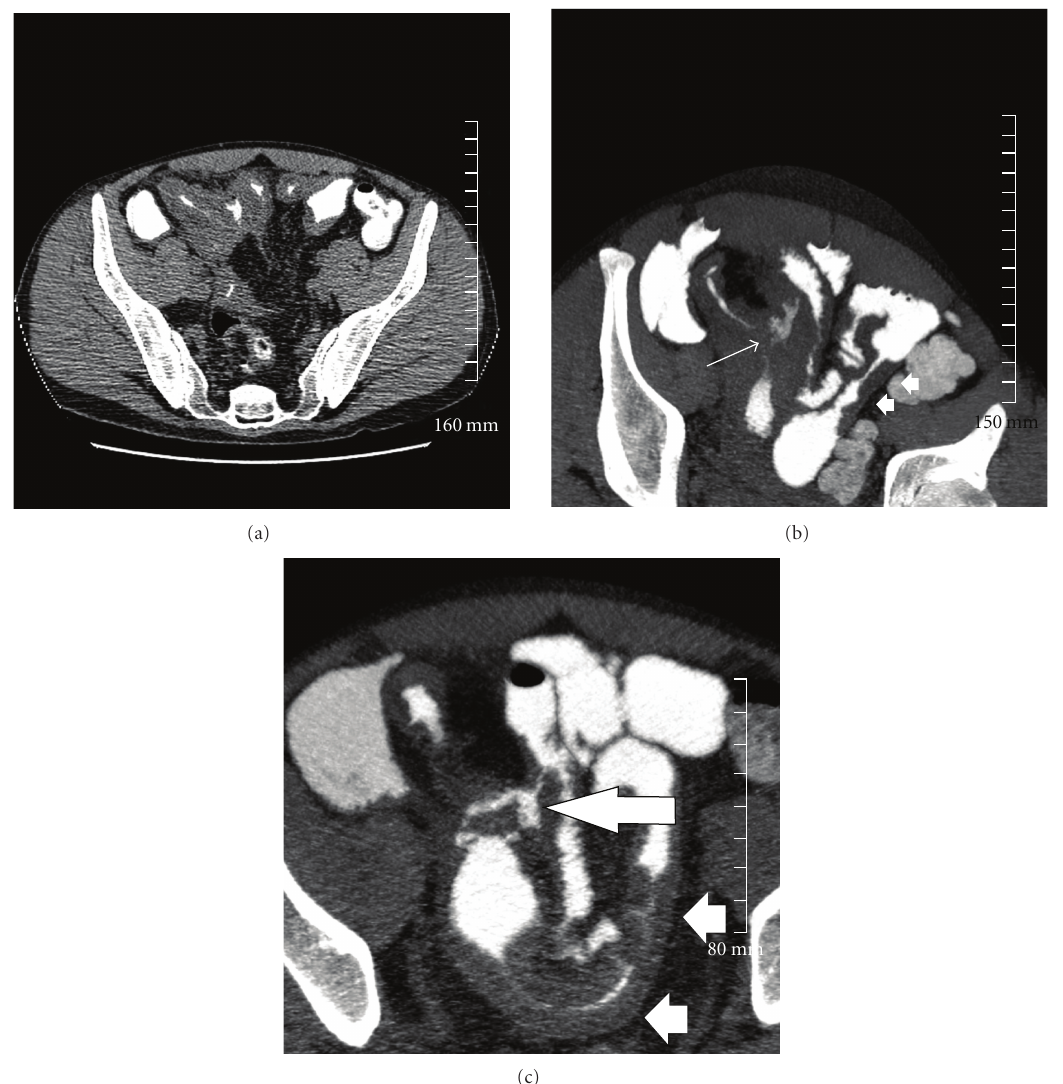
Figure 3: (a) 42-year-old male with Crohn’s disease. Raw supine, axial images acquired at 1.25mm slices prior to reconstruction on the 3D workstation. (b) The 7mm thick, axial-reconstructed MBCT oblique-axial reformats demonstrate an enteroenteric fistula (arrow). There is also a skip lesion in small bowel on the left side of the pelvis (white arrows heads). (c) Follow-up imaging 1 year later demonstrates that this enteroenteric fistulous connection persists (arrow). On the current study, the skip lesion seen previously demonstrates increasing thickness indicating worsening of disease